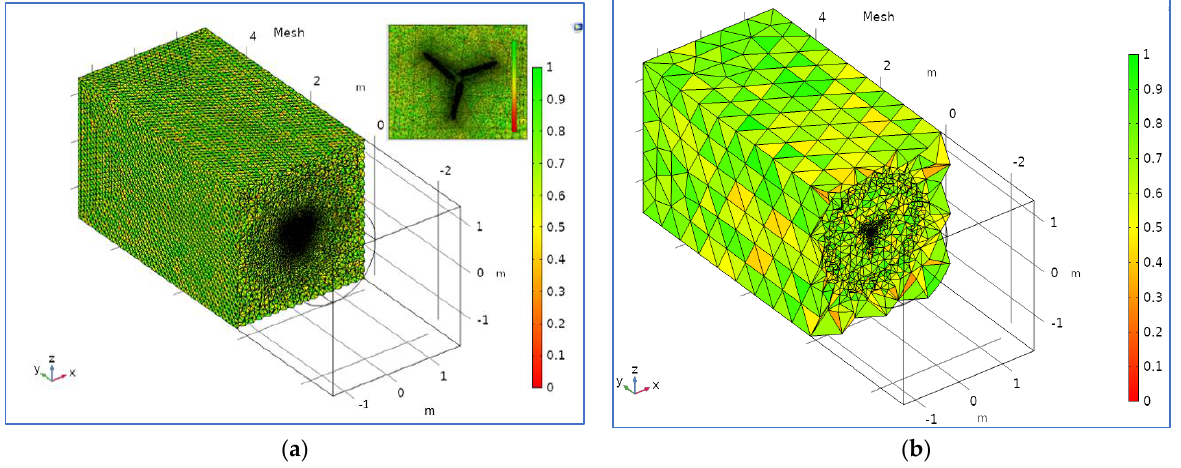
Figure 5. Meshed computational domain for ( a ) mesh 4 and ( b ) mesh 1.